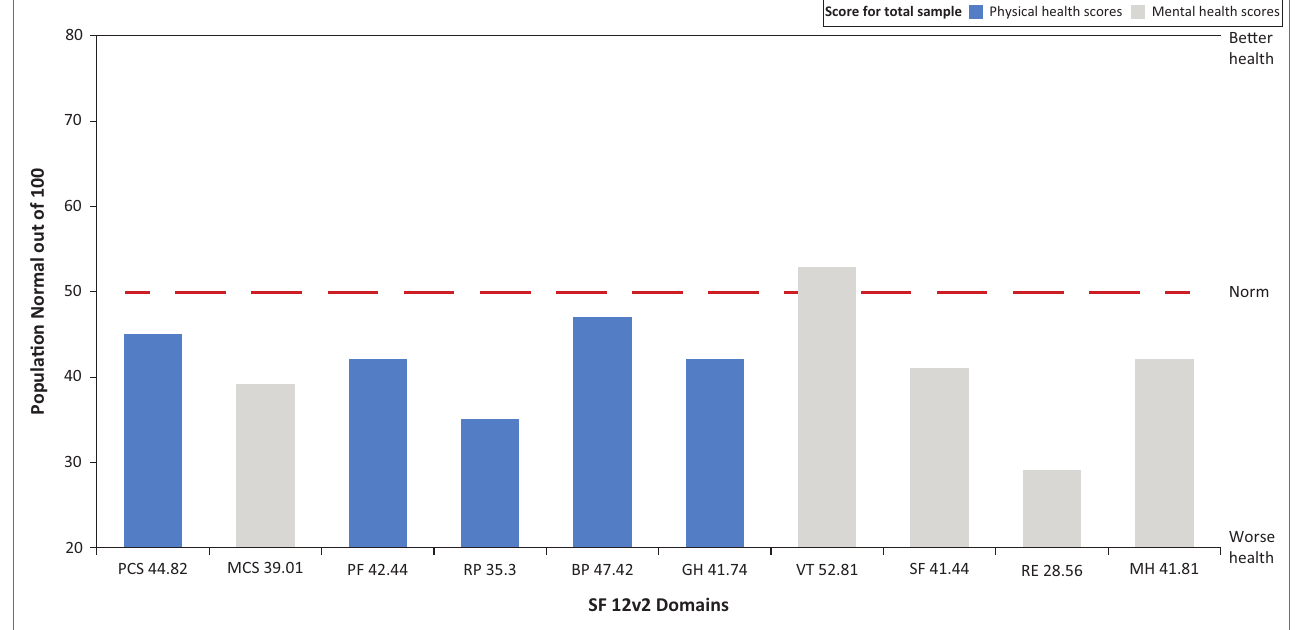
FIGURE 3: Short-form 12v2 domain scores. TABLE 2: Results of the 6-min walk test.